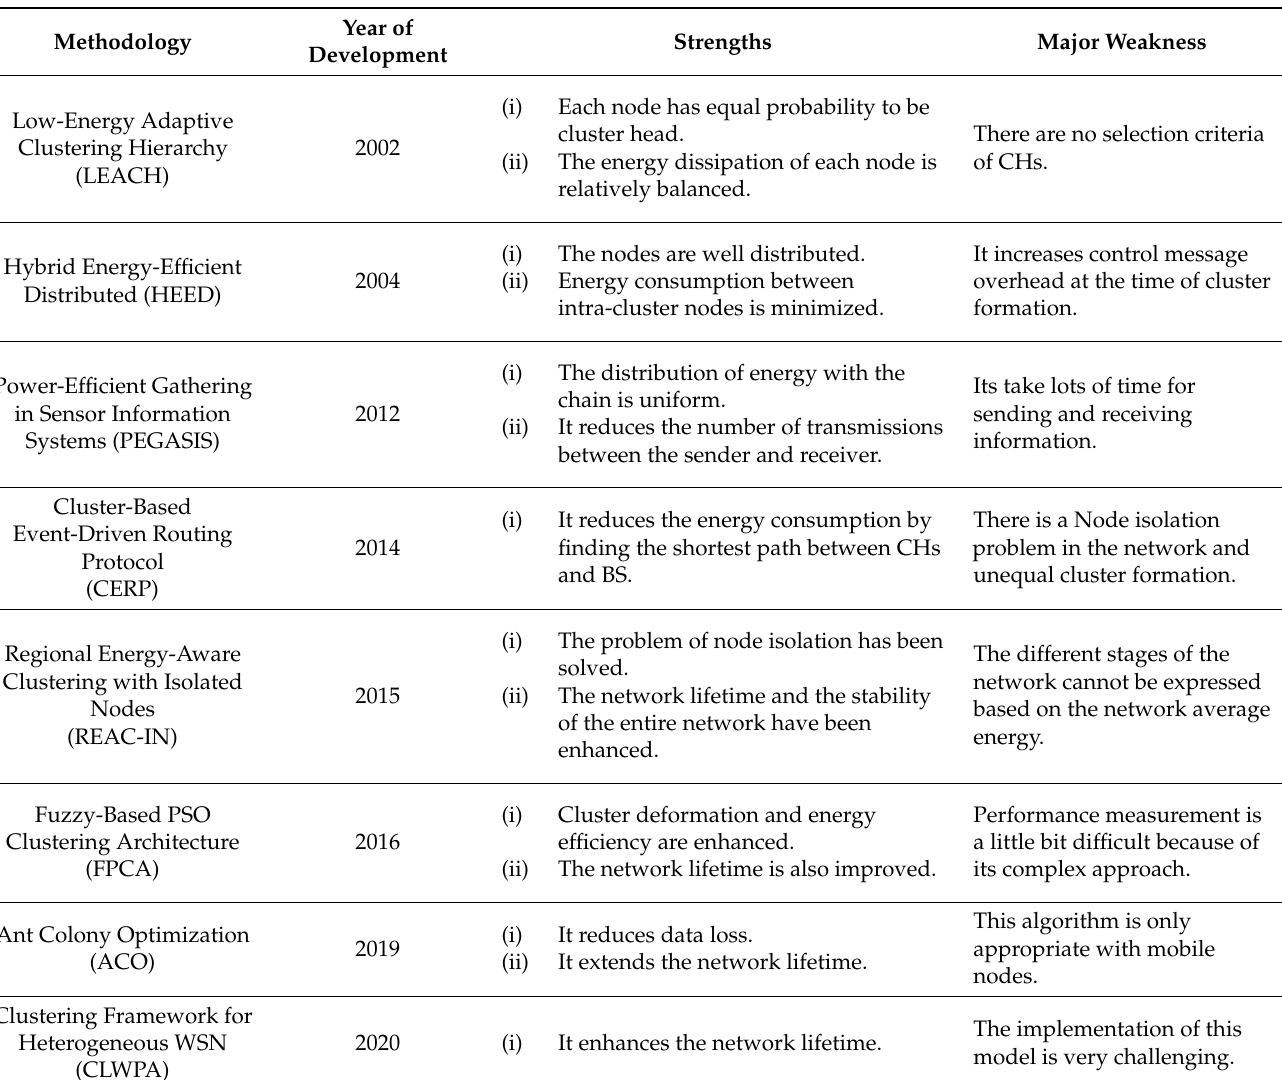
Table 2. List of previous reported methodologies/algorithms along with their strengths and their major